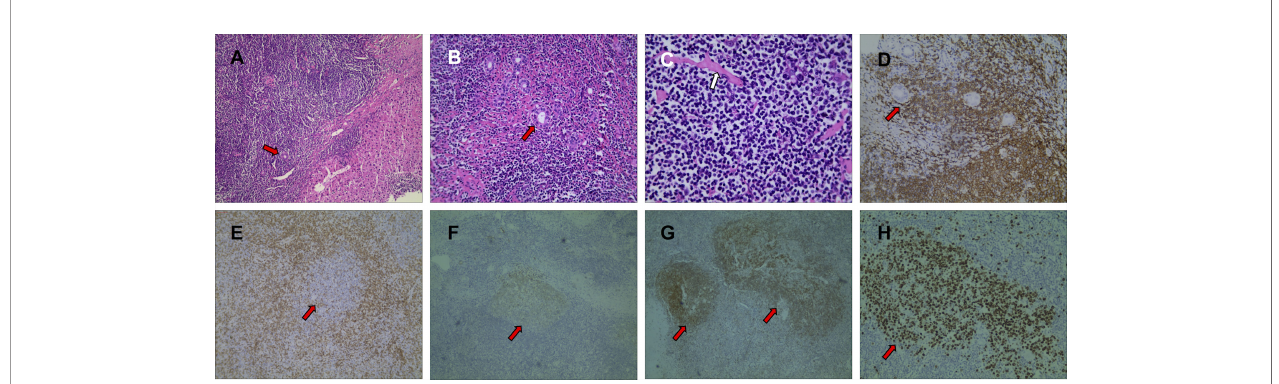
FIGURE 4 | Pathological fi ndings with hematoxylin-eosin (HE) staining showed that there were a large number of reactive proliferative lymphoid follicles in the tumor area, and the germinal center was composed of non-dysmorphic lymphocytes or plasma cells, fi brous collagen, and hyaluronic matrix, and remaining normal bile ducts (red arrows) can be seen along the edge of the lesion ( A , HE×100). Lymphoid tissues grow around the small bile ducts ( B , HE×200). A uniform red-stained matrix deposit can be seen in the lesion ( C , HE×400). The results of immunohistochemistry showed that CD20-positive lymphocytes grew around the small bile ducts ( D , IHC×200). CD3 ( E , IHC×100), CD10 ( F , IHC×40), CD23 ( G , IHC×40), Ki-67 ( H , IHC×40) staining showed reactive proliferative lymphoid follicles in the